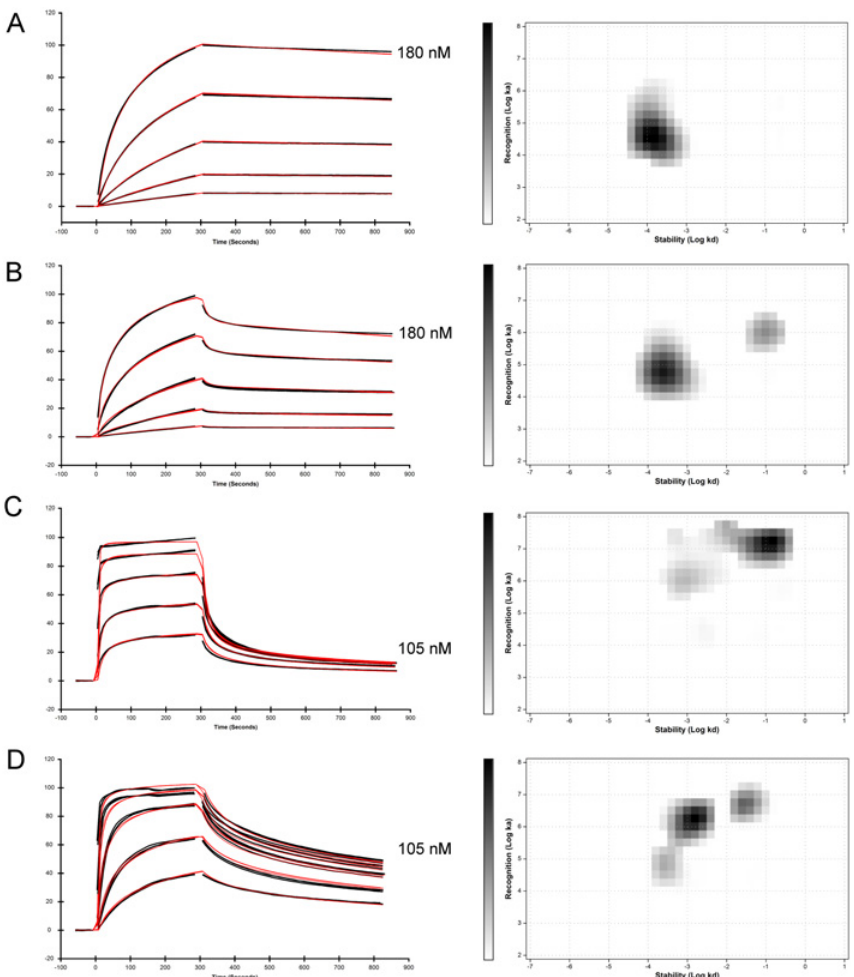
Figure 2. Deciphering the binding behavior of HRG1 β to HER3, investigated by different SPR assay setups and analyzed by Interaction Map. To determine the interaction of HRG1 β with HER3 in presence and absence of anti-HER3 antibody mAb208, the four SPR assays described in Fig. 1 were analyzed using Interaction Map (IM). The Multi-parameter fitting algorithm of IM was applied to the five concentrations used in the SPR assays (left column). The curve corresponding to the highest concentration is indicated in each sensorgram. The kinetic rate contributions are dissolved by IM (right column). Three replicates of each concentration are shown in black in each sensorgram. The third highest concentration of each assay was injected twice (n = 6). The applied IM fit was highlighted in red. (A — C) Murine antibody mAb208 was captured by immobilized rabbit anti-mouse antibody on CM5 sensor chip surface. (A) Injection of HER3 (ECD3). (B) Injection of pre-incubated HER3/HRG1 β . (C) Injection of HRG1 β . (D) Biotinylated HER3-Avi (bi- ECD3) was captured on a streptavidin-coated CAP sensor chip. Subsequently, HRG1 β was injected.